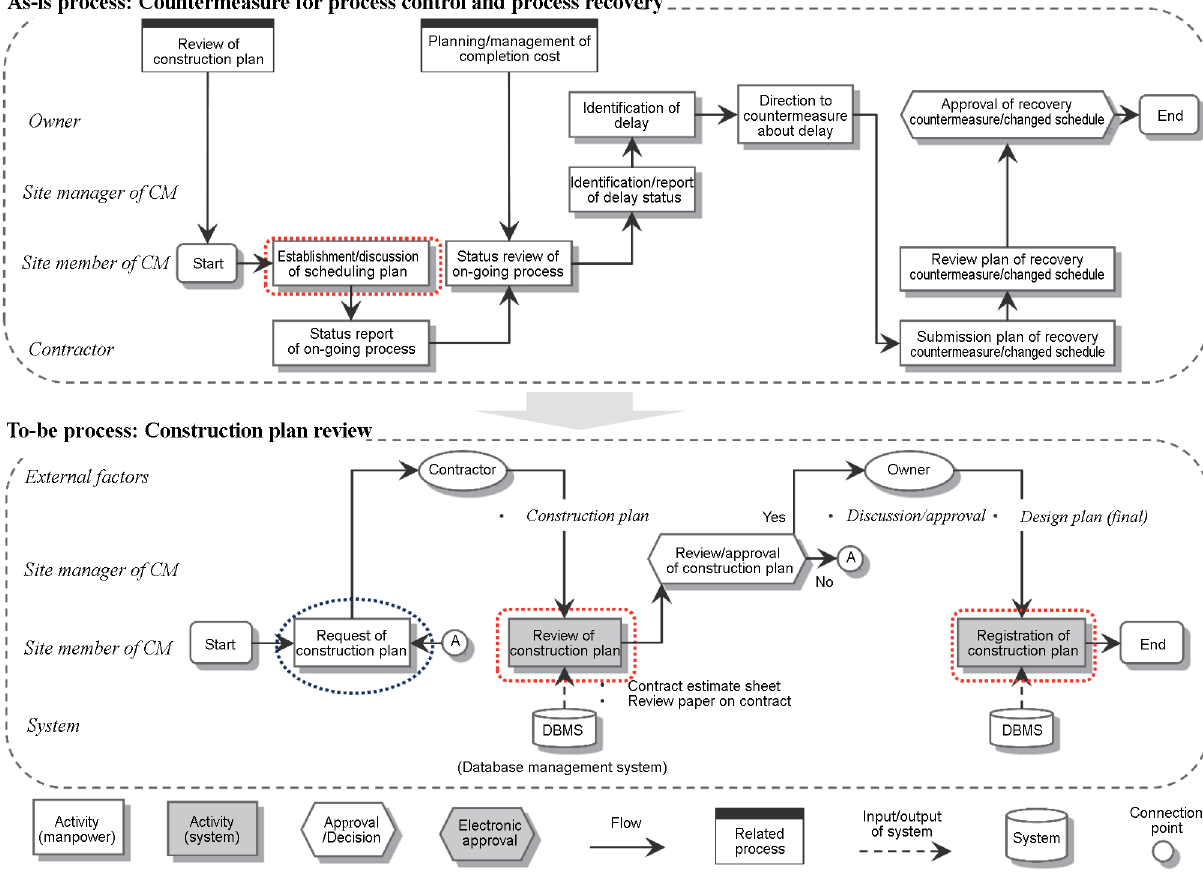
2. Example of a process map and a change from an as-is process to a to-be